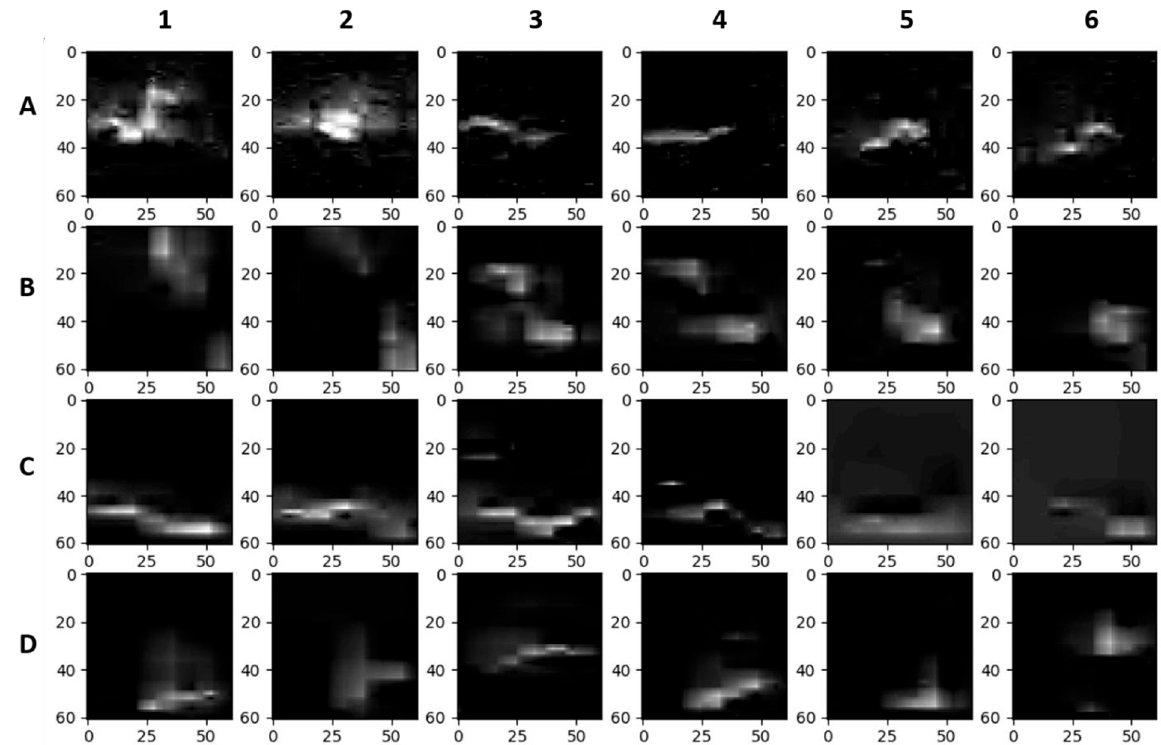
Figure 4. Example images (61 × 61 pixels) of eels and sticks after background removal and wavelet denoising: eels in the field (Row A ), sticks in the field (Row B ), eels in the laboratory (Row C ), and sticks in the laboratory (Row D ). Columns 1 and 2 are the same target at different times, the same for columns 3 and 4 as well as columns 5 and 6.